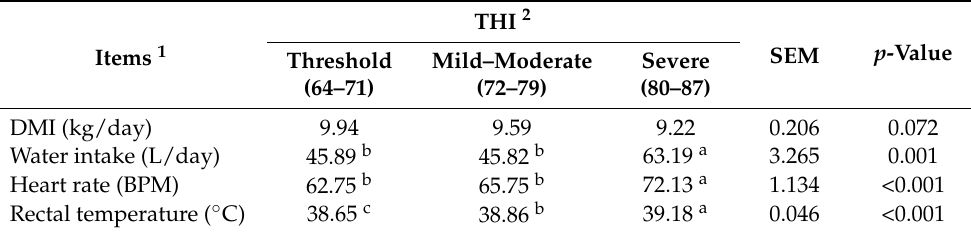
Table 2. Effect of heat stress level on dry matter intake, water intake, and physiological parameters in Korean native beef